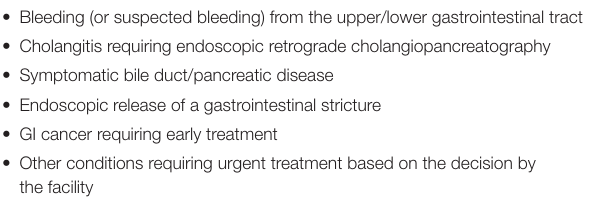
TABLE 2 | Conditions that may need urgent endoscopy regardless of COVID